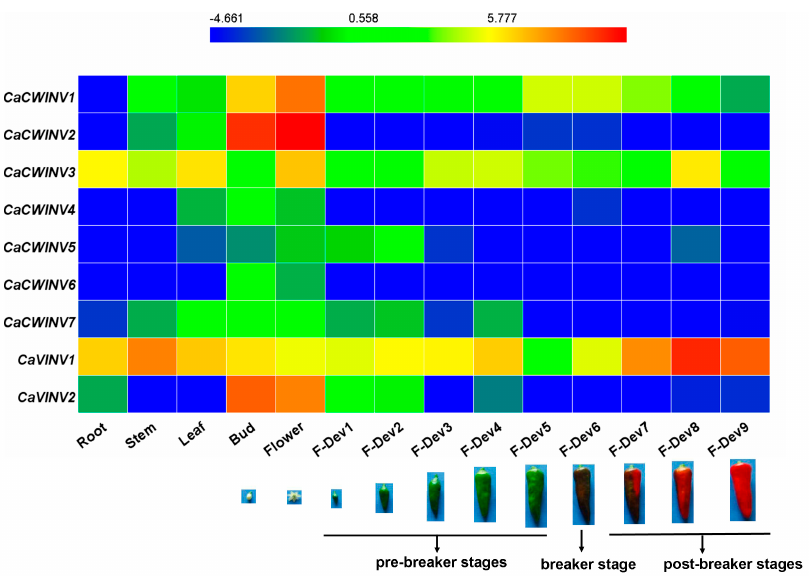
Figure 8. Expression profiles of nine pepper CaAINV genes in different tissues and developmental stages. The expression data were collected from Illumina RNA-sequence data from the genome sequences of the pepper cultivar, Zunla-1, [12]. Images of pepper fruit developmental stages were cited from Qin et al. [12]. The fragments kilobase of exon model per millon mapped reads (FPKM) values were log 2 transformed and the heat map was generated using the HemI (Heatmap Illustrator, version 1.0) software package. The bar at the top represents log 2 -transformed values. Genes, highly or weakly expressed, in various tissues are colored blue and red, respectively.